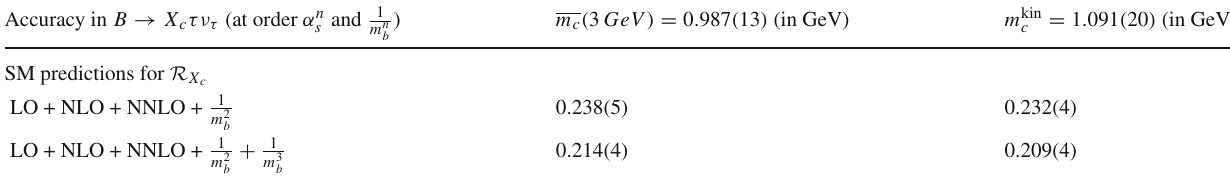
Accuracy in B → X c τν τ (at order α n s and 1